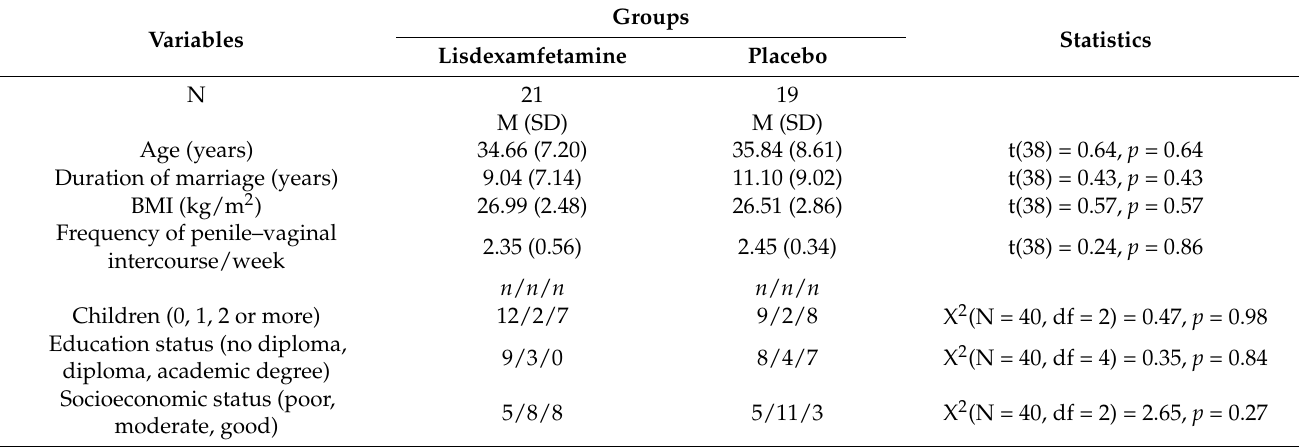
Table 1. Descriptive and inferential statistical overview of sociodemographic baseline characteristics between participants in the lisdexamfetamine and the placebo condition.